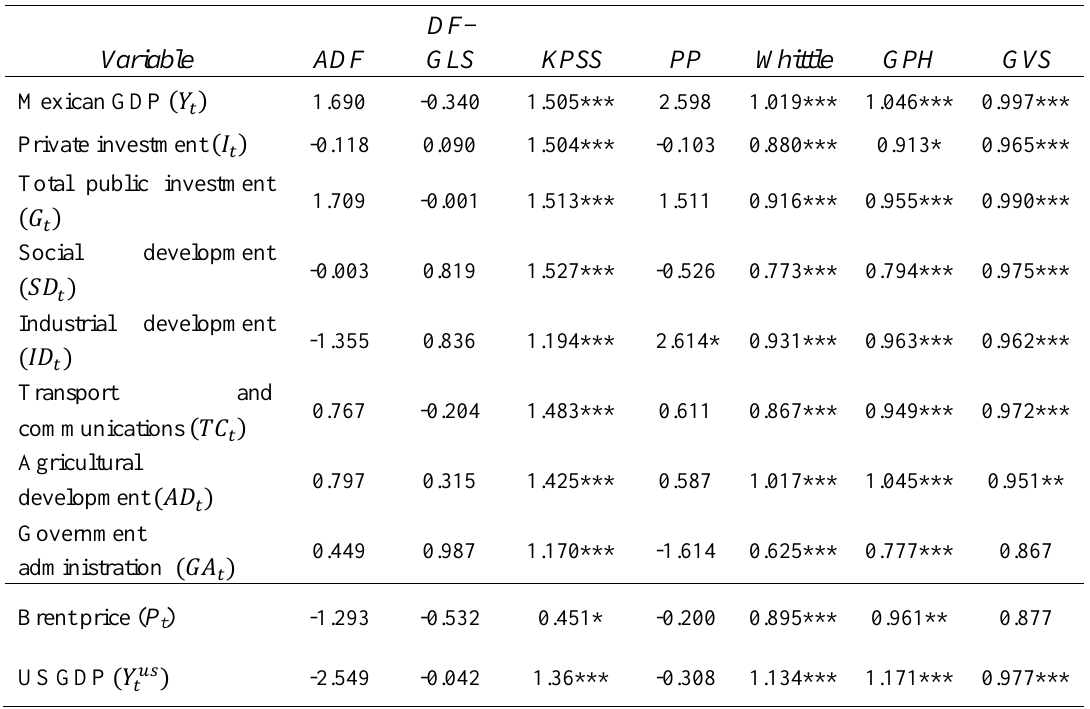
Table 1 : Unit-root and persistence